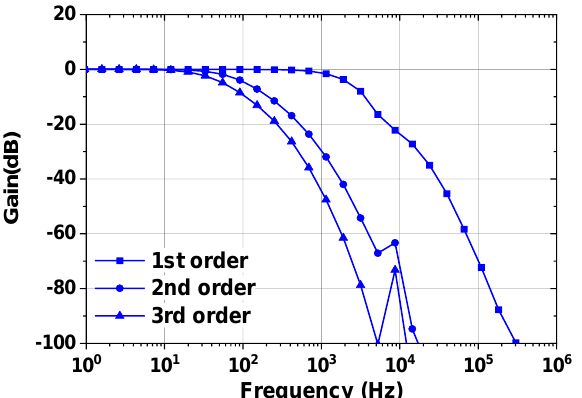
Figure 15. Schematic of the low-pass filter.